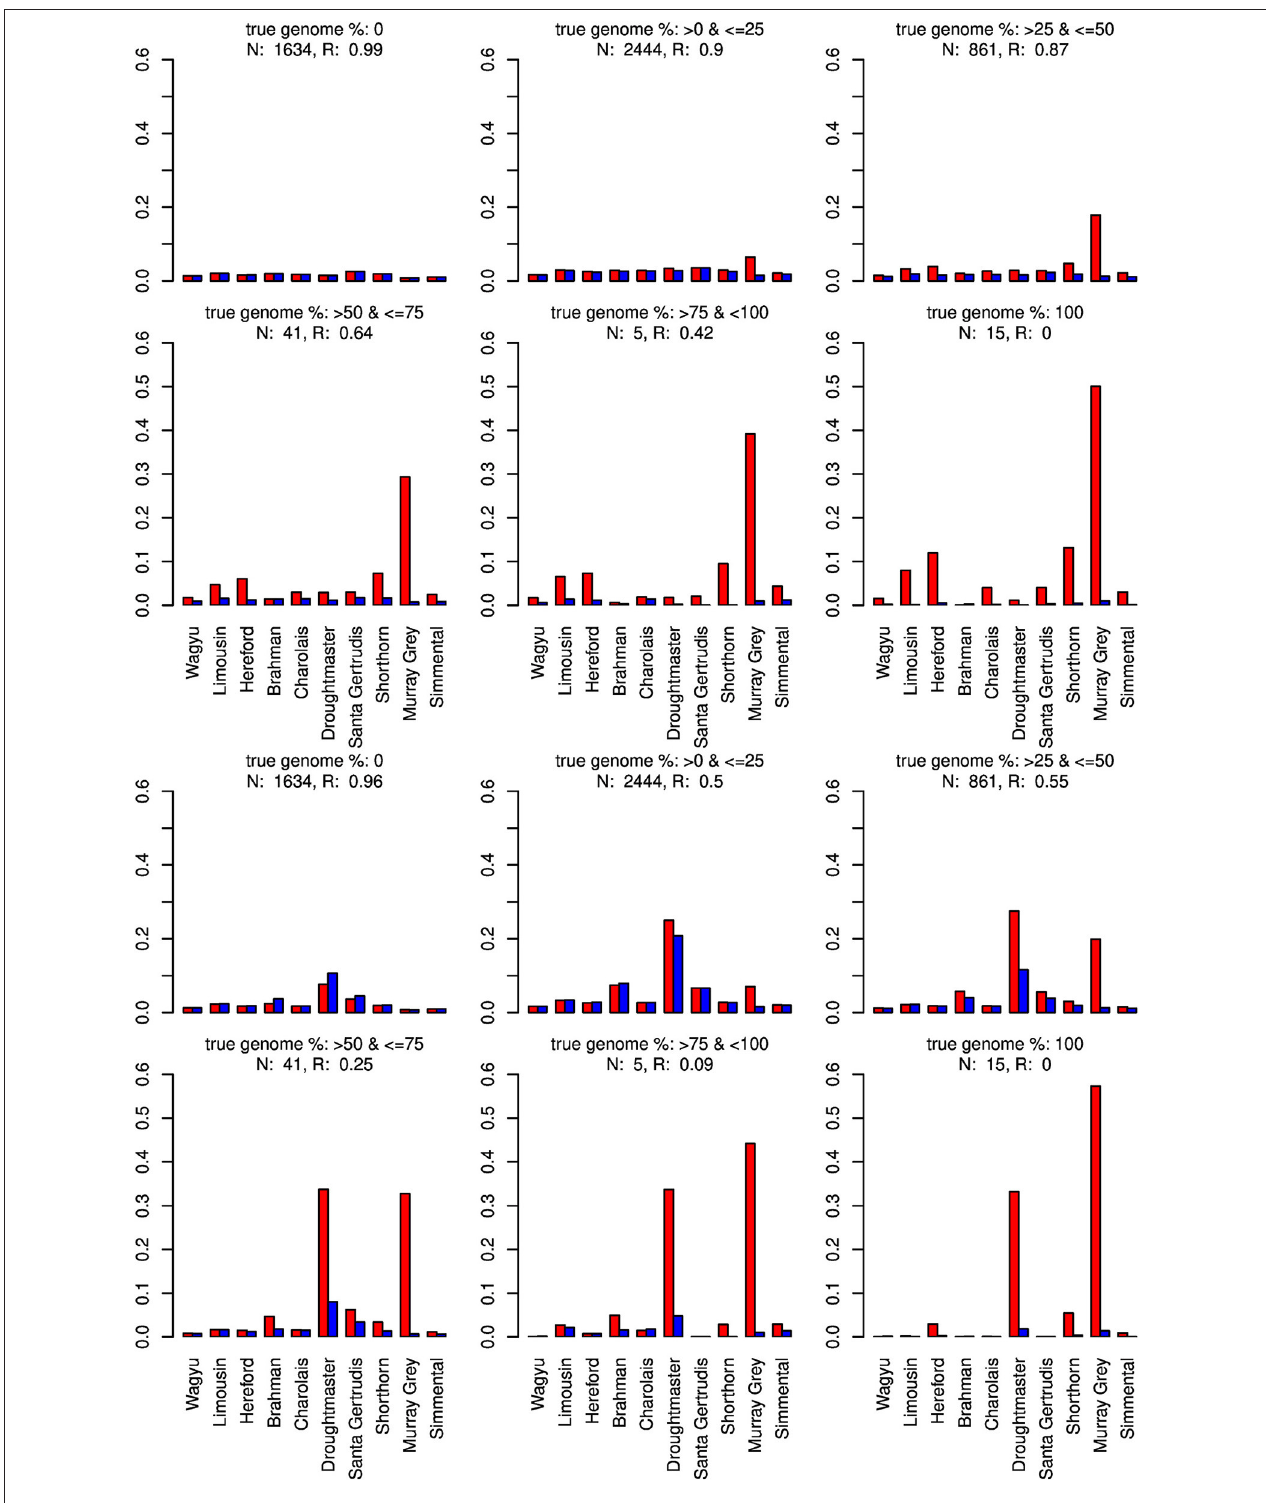
FIGURE 8 | Distribution of the average absolute estimation error within possible founder breeds for the 25 cross-over cattle data set from a model using all 11 breeds (blue) and a model excluding the Angus breed (red). Results are shown for categories of artificially admixed animals having 0%, > 0%– ≤ 25%, > 25% −≤ 50%, > 50%– ≤ 75%, > 75%– < 100%, and 100% genome of the excluded breed. The graphs in the upper two rows show the results from CGR the lower two rows those from ADMIXTURE. R, correlation between the true and the estimated genome proportion when the Angus breed was excluded; N, number of used admixed individuals for calculating